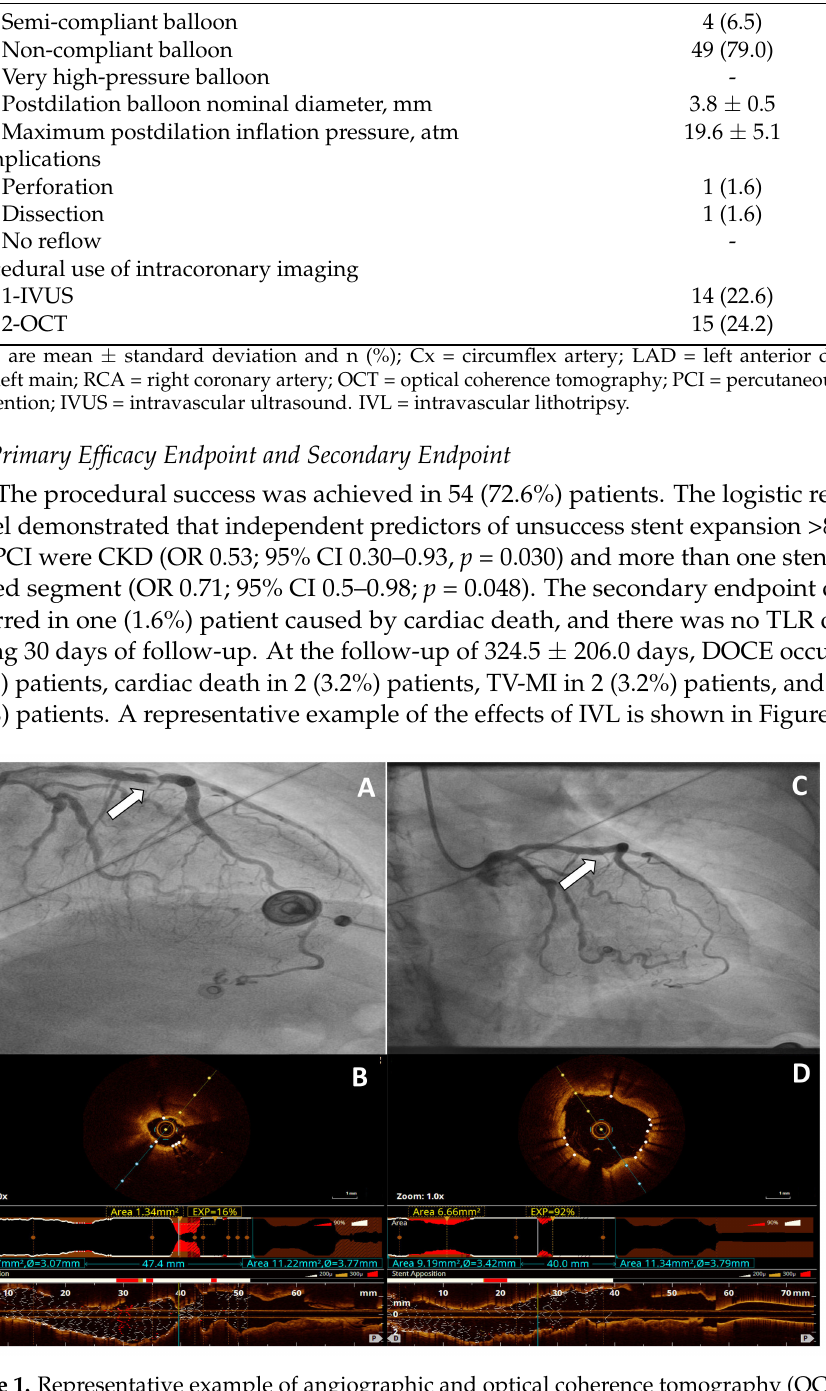
Figure 1. Representative example of angiographic and optical coherence tomography (OCT) images of Shockwave Intravascular Lithotripsy (IVL) for stent underexpansion caused by severe coronary artery calcification. ( A ) Angiography demonstrates significant lesion (arrow) in the left anterior descending artery caused by underexpanded stent. ( B ) OCT cross-sectional and longitudinal image acquired before IVL demonstrates deep calcium fractures and 16% stent expansion ( C ) Angiography demonstrates improvement in the area of stenosis (arrow) after IVL. ( D ) OCT cross-sectional and longitudinal image acquired post-IVL demonstrates 92% stent expansion. ‘D’ = distal; ‘P’ =